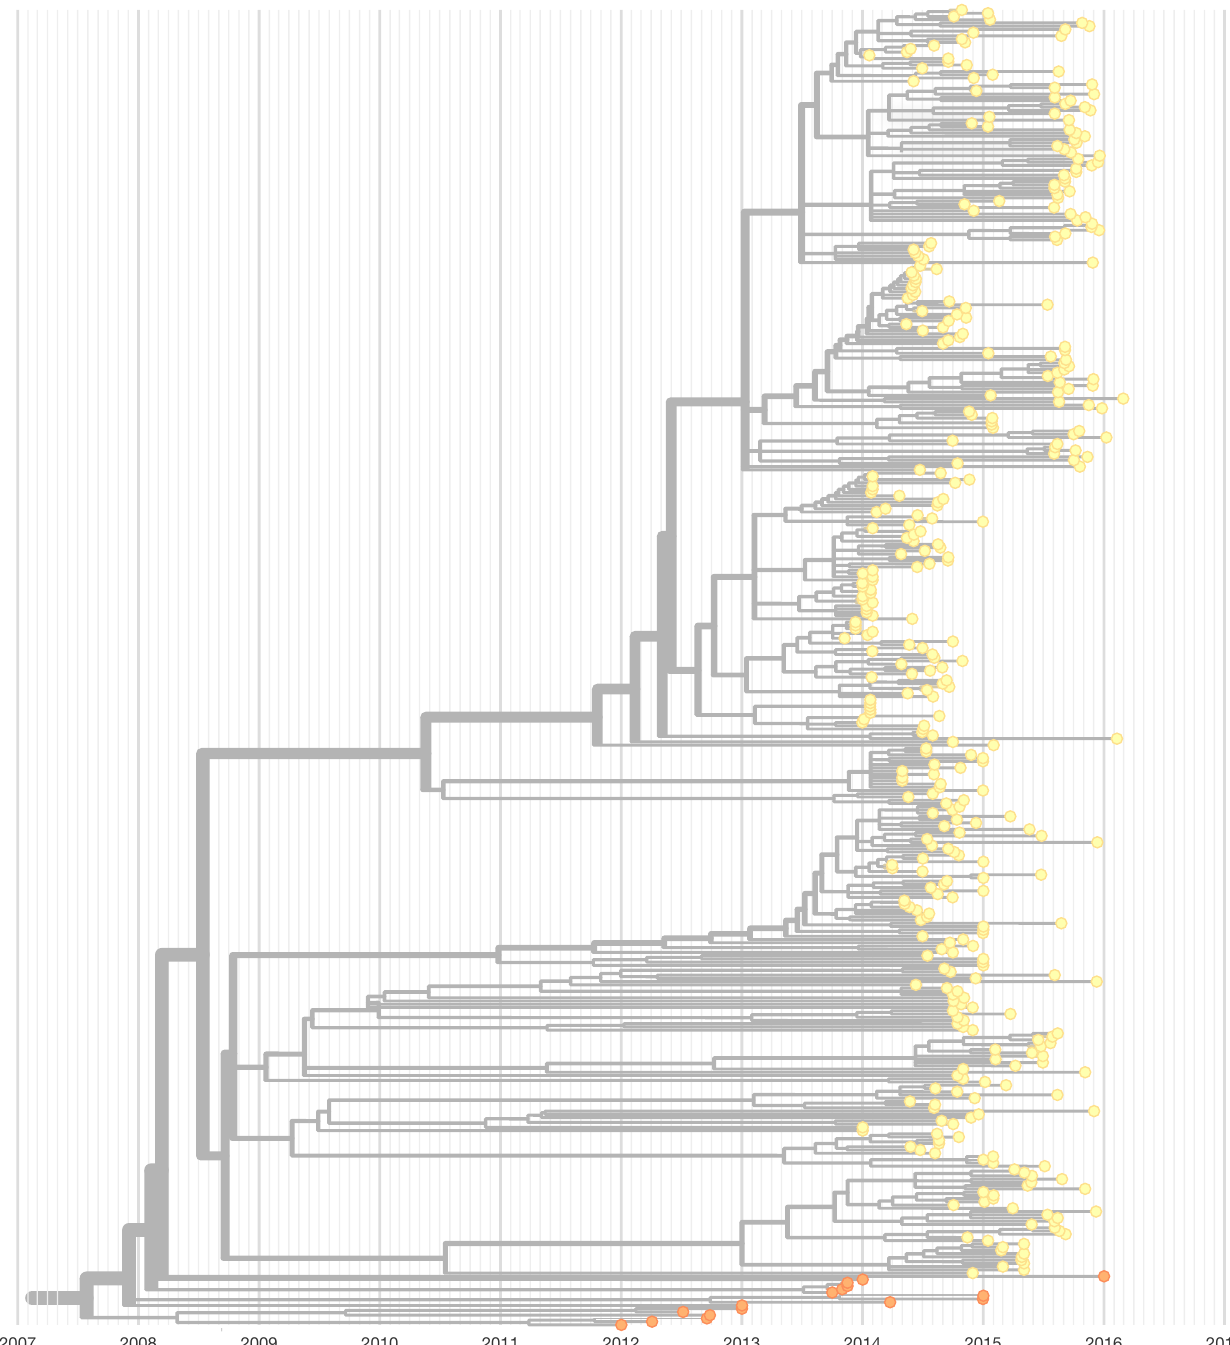
Figure A1. Nextstrain time-resolved maximum likelihood phylogeny, highlighting a subtree that comprises isolates from the Asian Urban (orange) and Asian Urban-American (yellow) lineages. Inferred TMRCA of the shown subtree is July 2007 (confidence interval November 2006–March